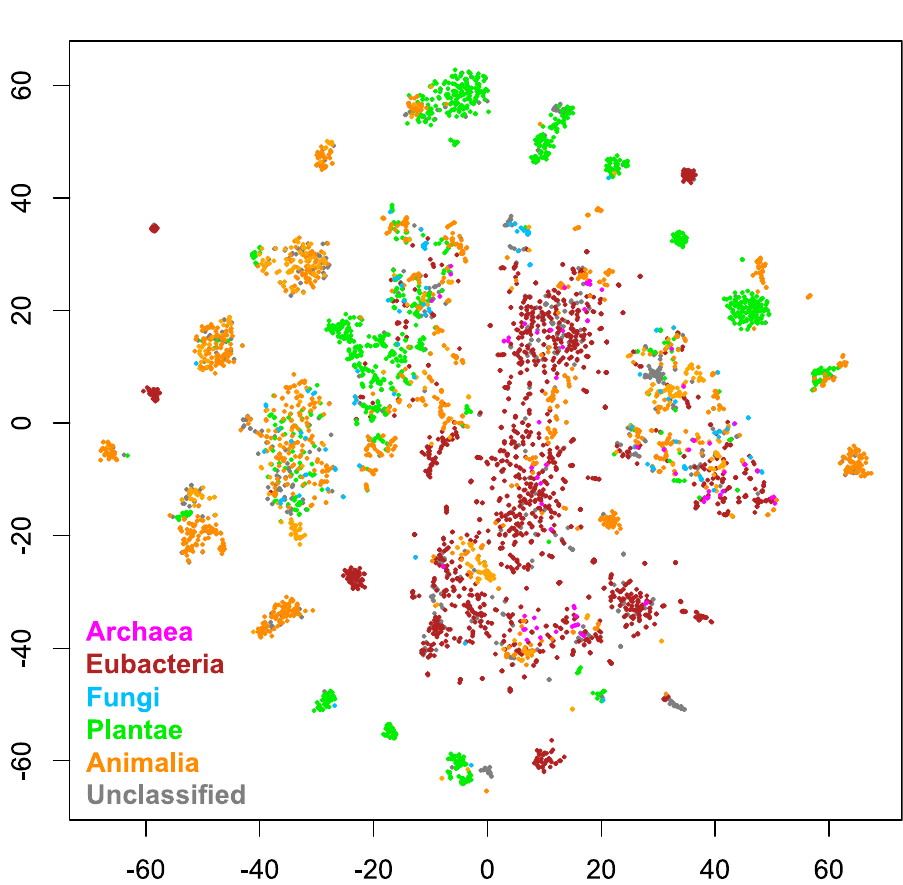
Fig 4. t-SNE plot of 5,817 viruses from RefSeq, grouped by mutual information of genes in common and 4-mer frequency. Points are colored by host kingdom: magenta = Archaea, maroon = Eubacteria, sky blue = Fungi, lime green = Plantae, orange = Animalia, and gray =